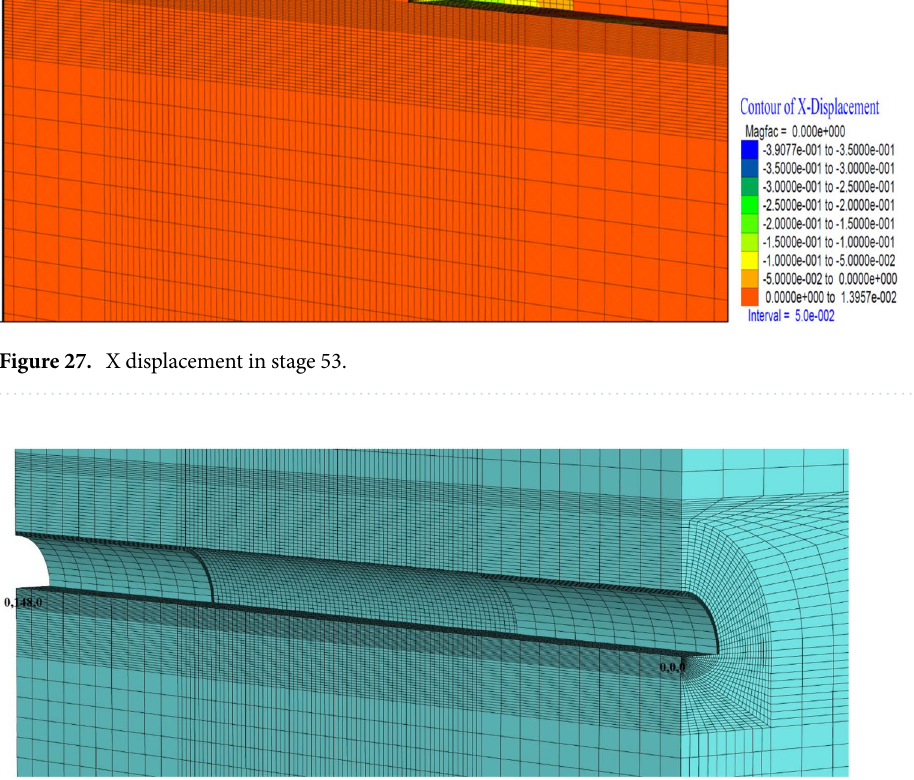
Figure 28. Tunnel excavation situation after stage